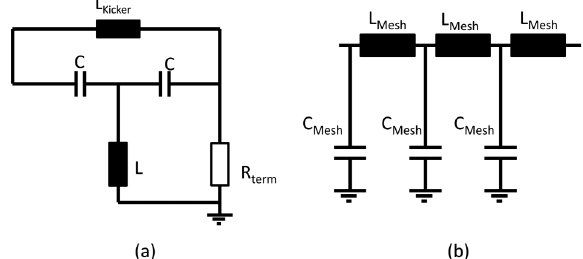
FIG. 36. (a) Double-bridged T-network and (b) traveling wave kicker. For the double-bridged T-network the required capaci- tance C can be calculated from the kicker inductance and the termination resistance R : C ¼ L inductance can be calculated from L ¼ L